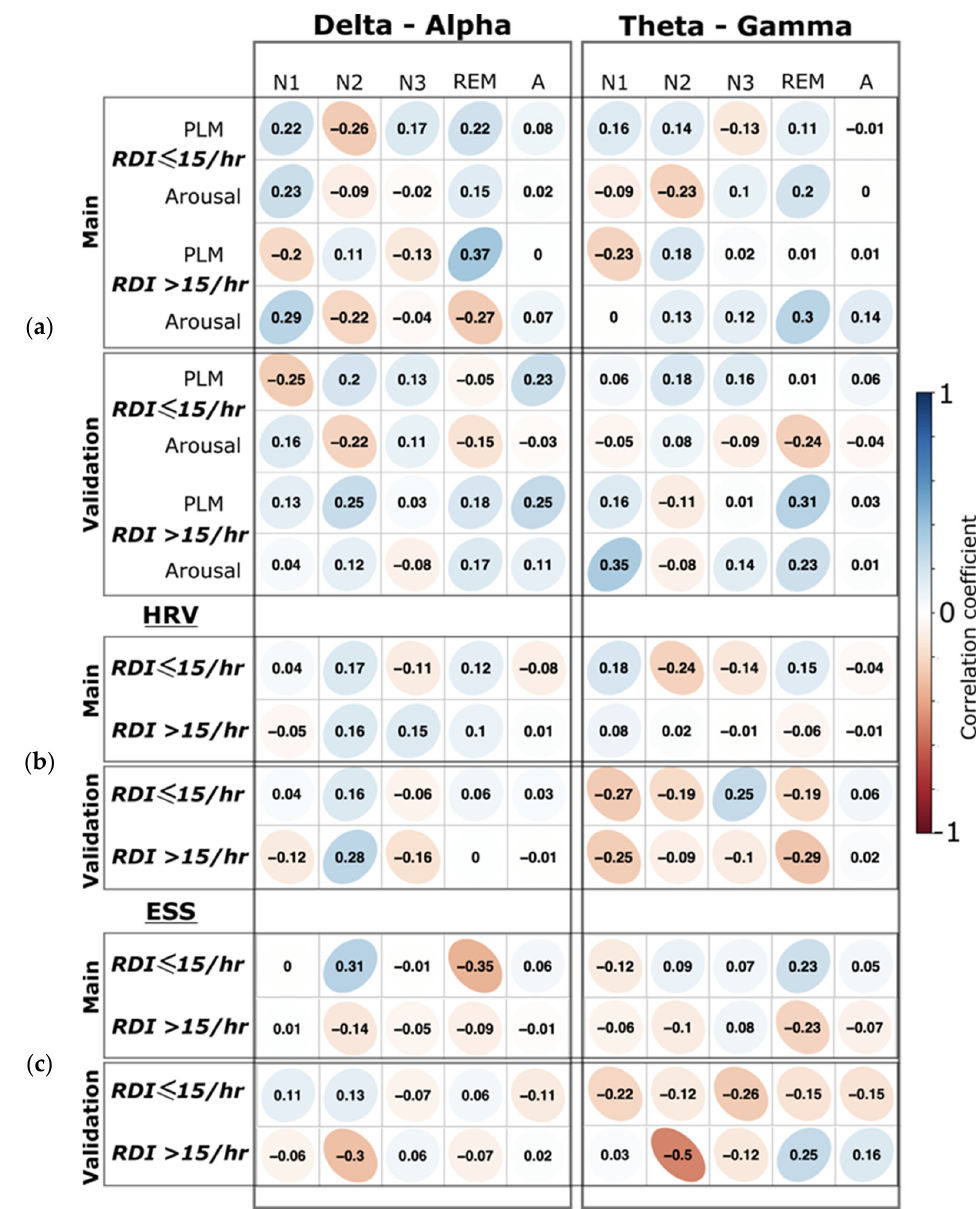
Figure 6. Correlation of clinical parameters with CFC measures. ( a ) The correlation coefficients between arousal and periodic leg movement indices (PLM) to the phase–amplitude cross-frequency coupling (PACFC) for each sleep stage separately. For both delta–alpha and theta–gamma, PACFC are separated by the columns. ( b ) The correlation coefficients between the heart rate variability (HRV) and the PACFC in the different sleep stages are separated by columns. ( c ) The correlation coefficients between Epworth Sleepiness Score (ESS) and the PACFC in different sleep stages. Correlations for the main and the validation groups are shown in each row separately. The r values are shown for correlation. All correlations were non-significant ( p > 0.05).